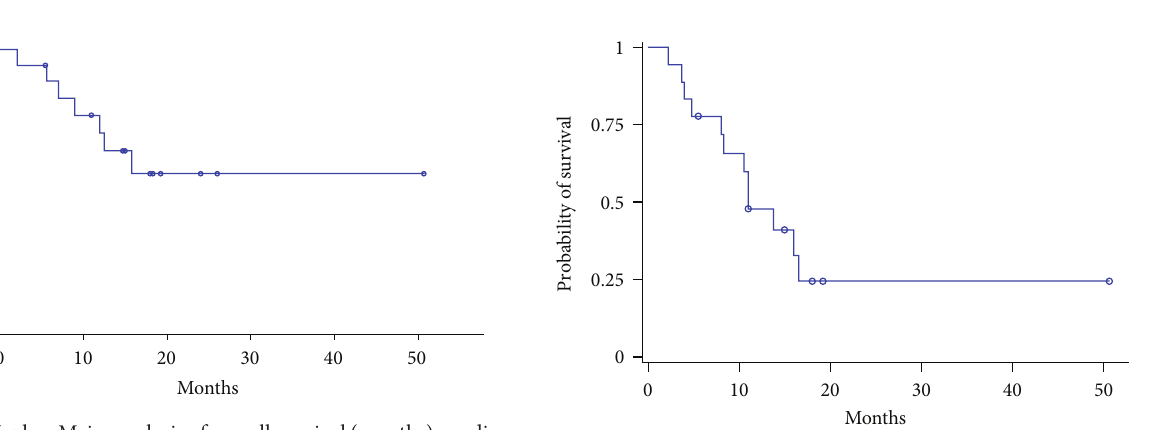
Figure 3: Kaplan-Meier analysis of progression-free survival (months): median progression-free survival was 11.0 months ( 95 % CI: